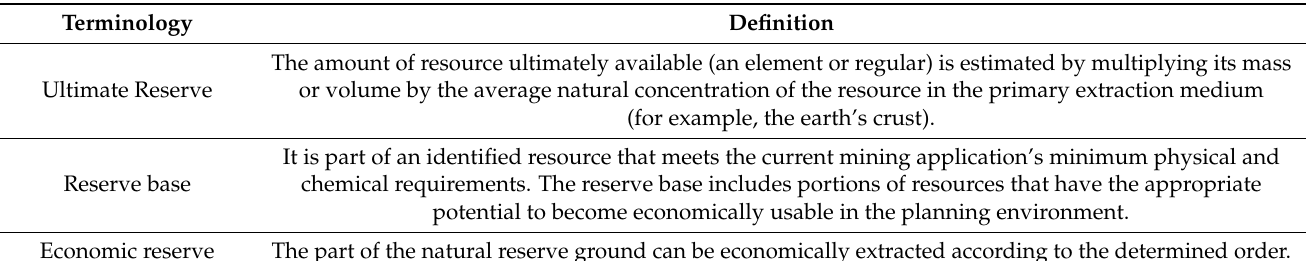
Table 1. Types of reserves and definitions